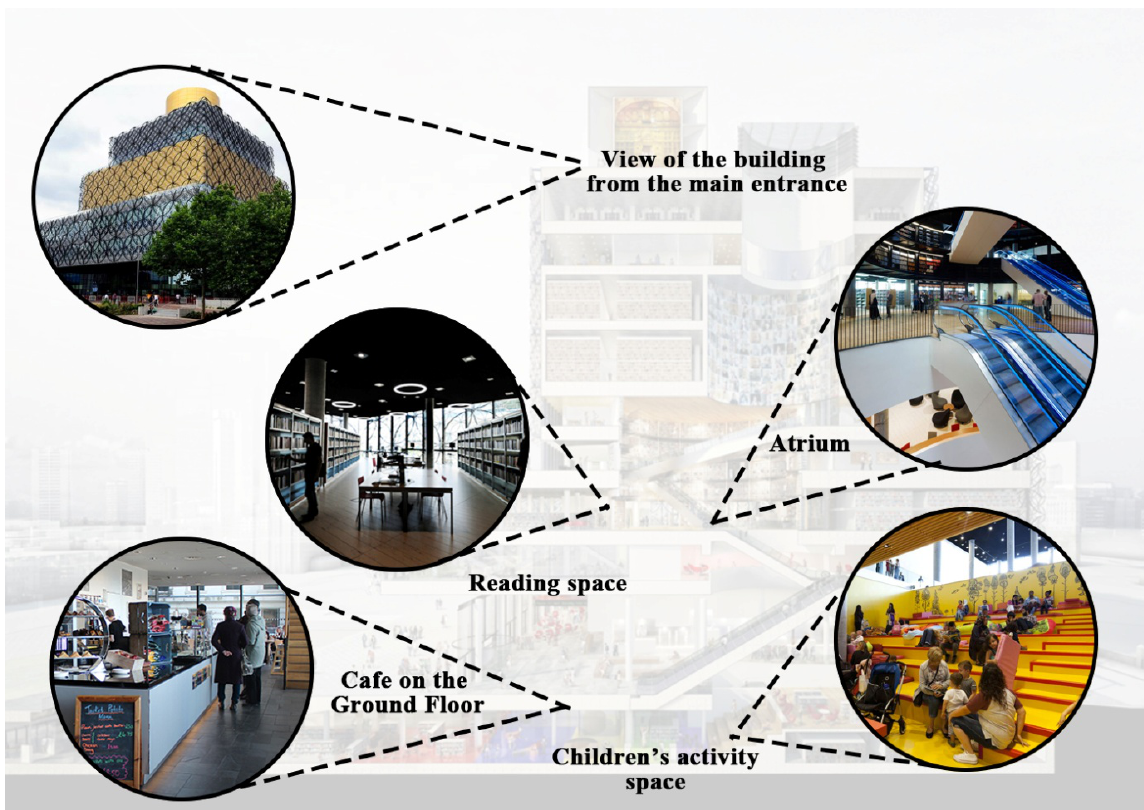
Figure 1: Examples of the architectural characteristics of the Library of